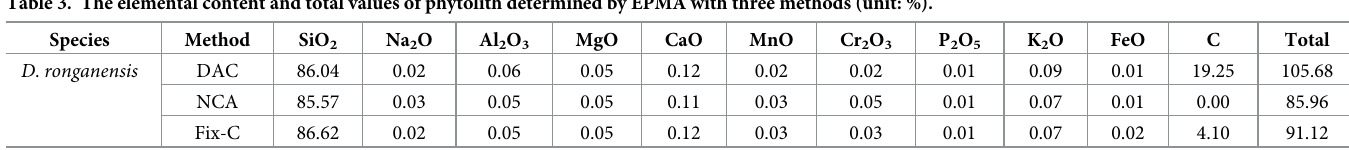
Table 3. The elemental content and total values of phytolith determined by EPMA with three methods (unit: %).